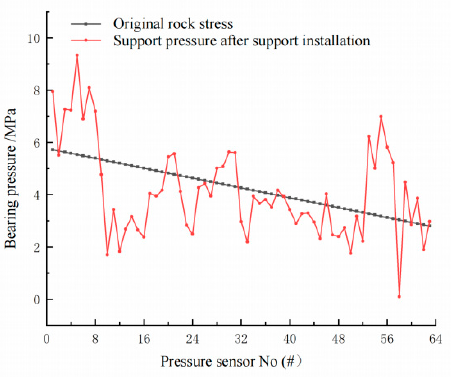
Figure 14. Bearing pressure of the floor after the support installed in the working